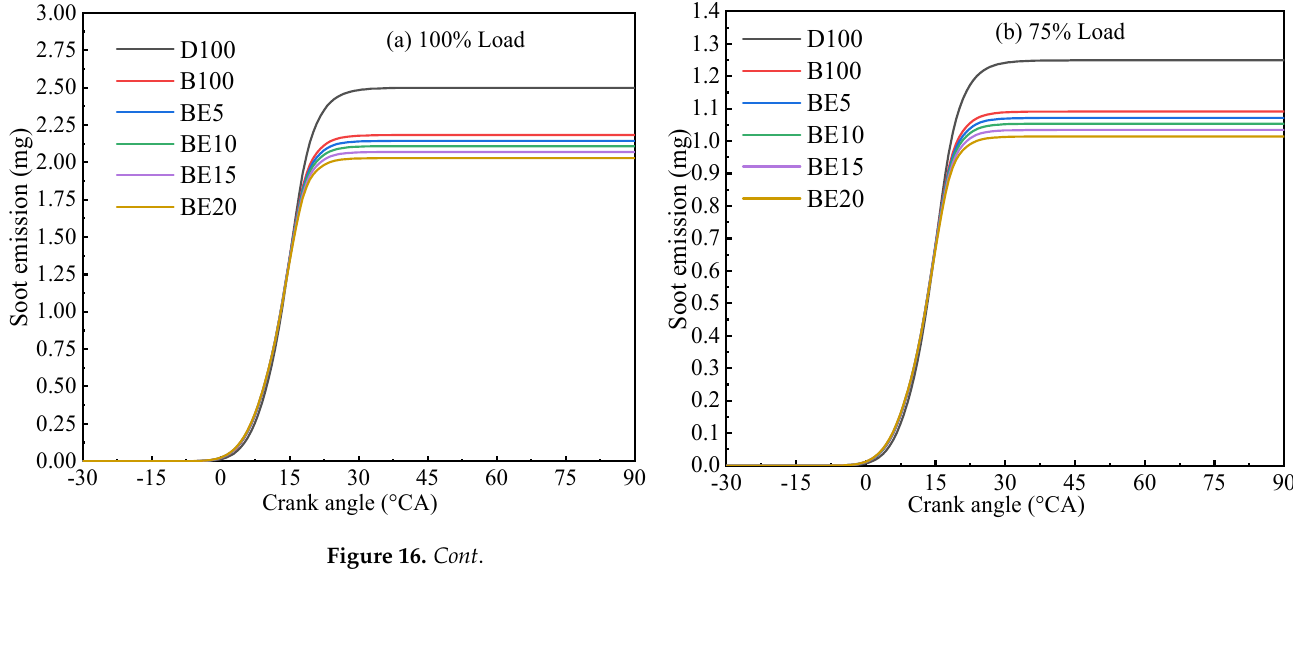
(d) 25% Load Figure 16. Cont